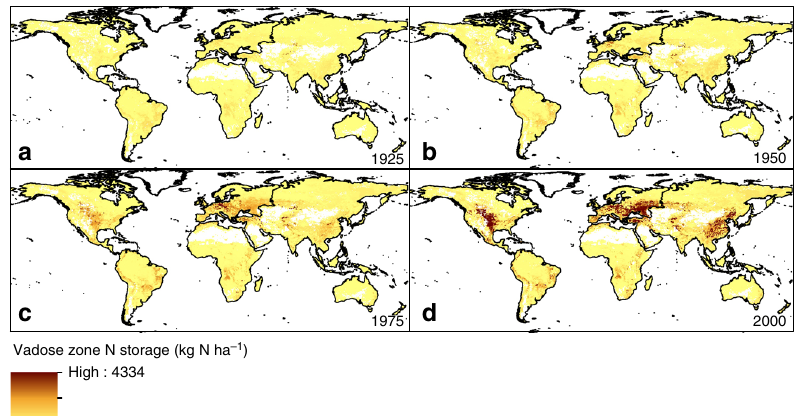
Fig. 2 Spatial distribution of nitrate stored in the vadose zone. Global vadose zone N storage (in kg N ha − 1 ) is shown for 1925 ( a ), 1950 ( b ), 1975 ( c )